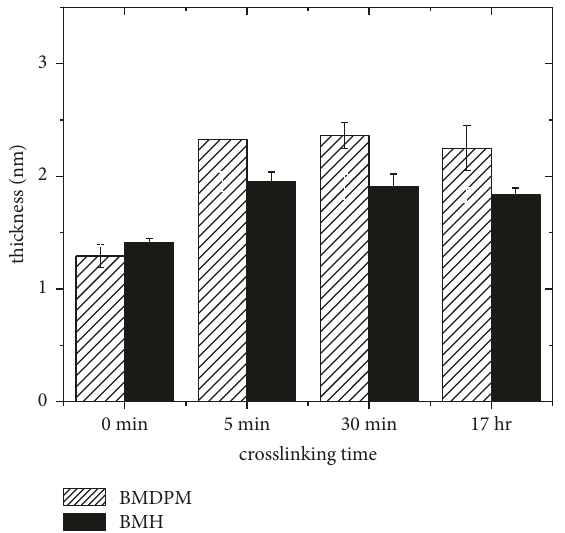
Figure 5: Kinetics of linker incorporation as indicated by changes in monolayer thickness. The error bars correspond to standard deviation of two independent EIS measurements performed on the same sample.